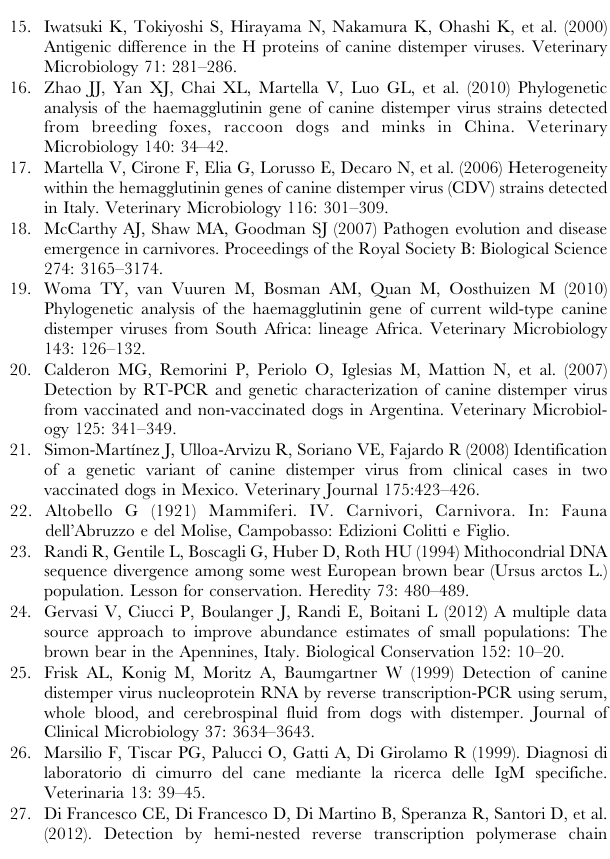
Table S1 Genbank accession numbers of CDV